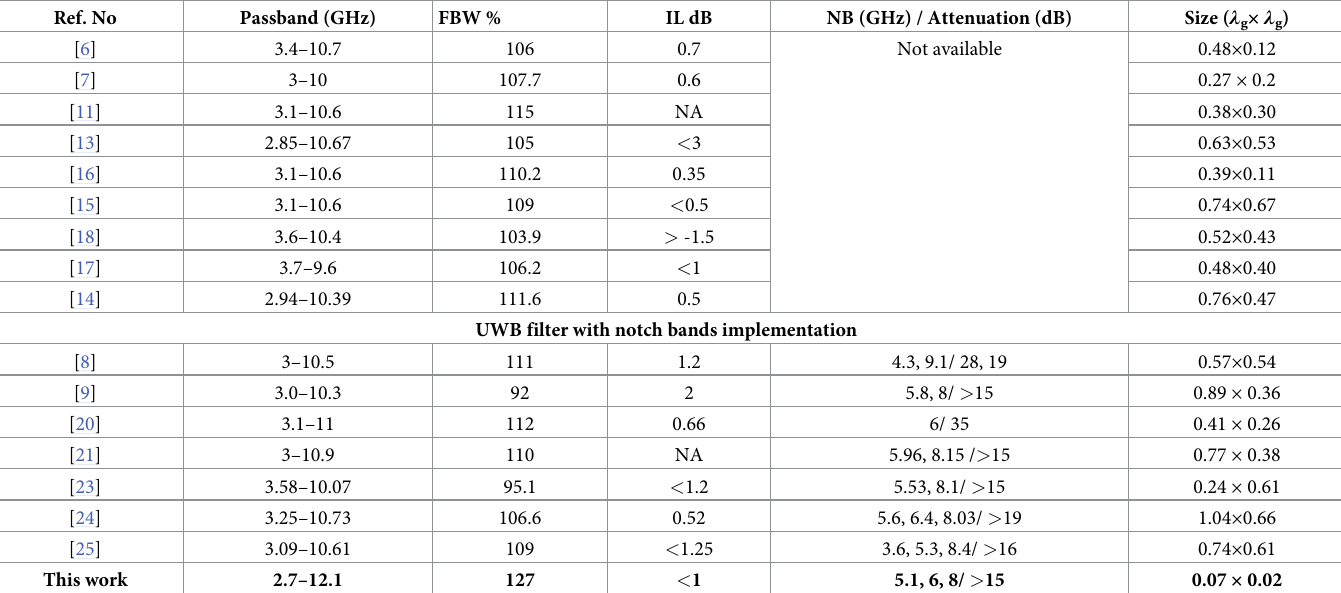
Fig 14. Optimized simulated and measured outcomes of the proposed filter. https://doi.org/10.1371/journal.pone.0268886.g014 Table 4. Comparison of this work with other reported